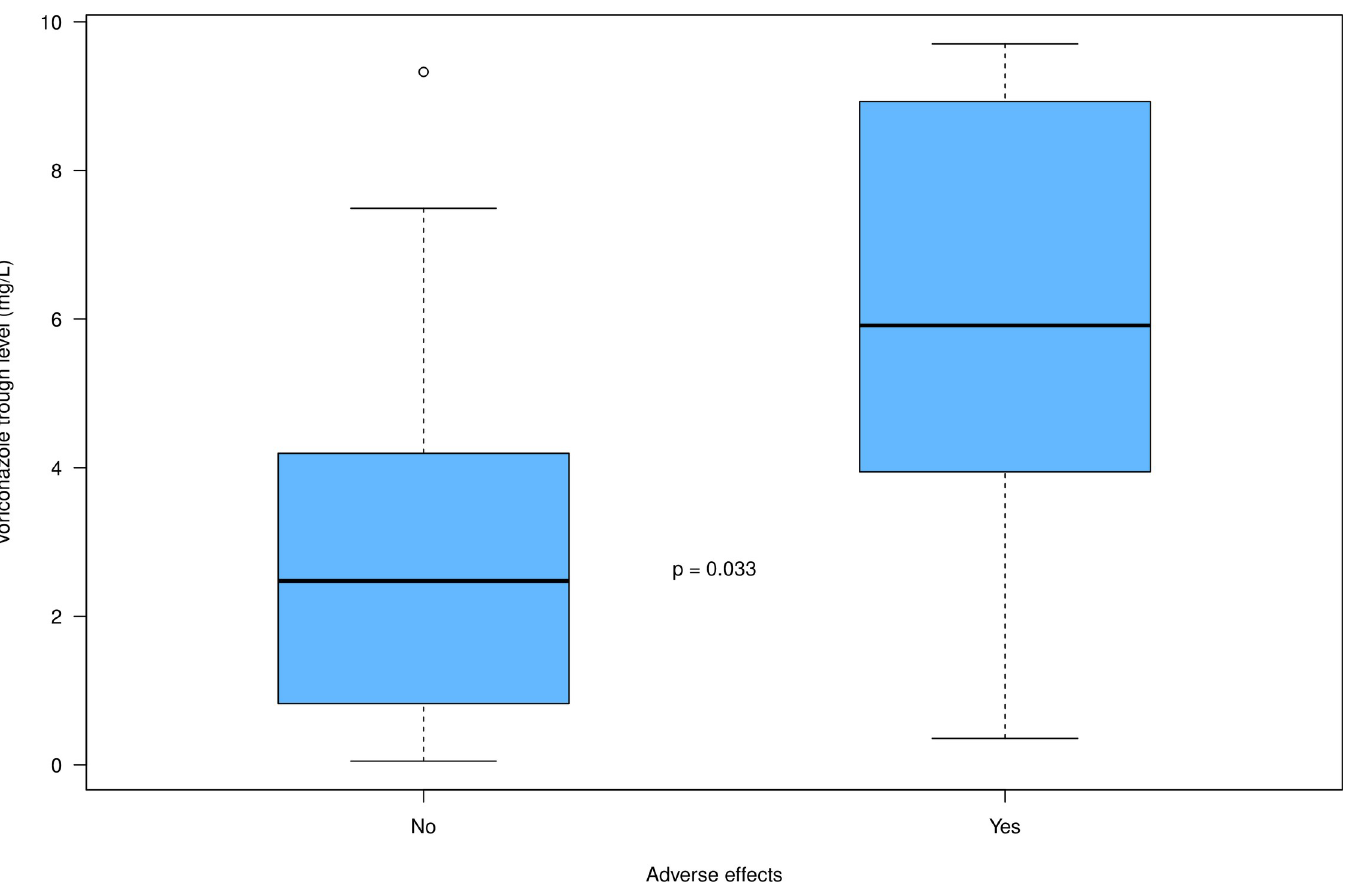
Fig 3. Box plots of voriconazole trough levels according to the presence or absence of adverse effects. For each box of the box plots, the centre line represents the median, the bottom line represents the 25th percentiles and the top line represents the 75th percentiles. The whiskers of the box plots show 1.5 interquartile range (IQR) below the 25th percentiles and 1.5 IQR above the 75th percentiles, and outliers are represented by small circles.